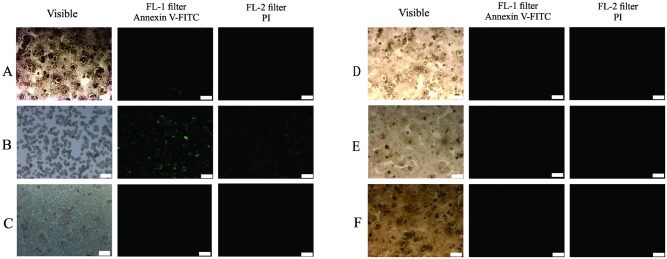
Annexin V-FITC and propidium iodide staining of hepatocytes treated by 1,3,4-thiadizolium derivatives (the experimental conditions are described in the Materials and Methods section 2.5.3).Hepatocytes were incubated with derivatives at 25 μM for 20 h. The images (10X magnification) were captured with an AXIOVERT 40CSFL fluorescence microscope. The scale is indicated by white bars representing 100 μm. The annexin V-FITC-positive cells are stained in green, and the PI-positive cells in red. The images represent (A) control (untreated cells), (B) ASA positive control at 20 mM, (C) MI-D, (D) MI-J, (E) MI-4F and (F) MI-2,4diF. The figures represent three different experiments in triplicate.